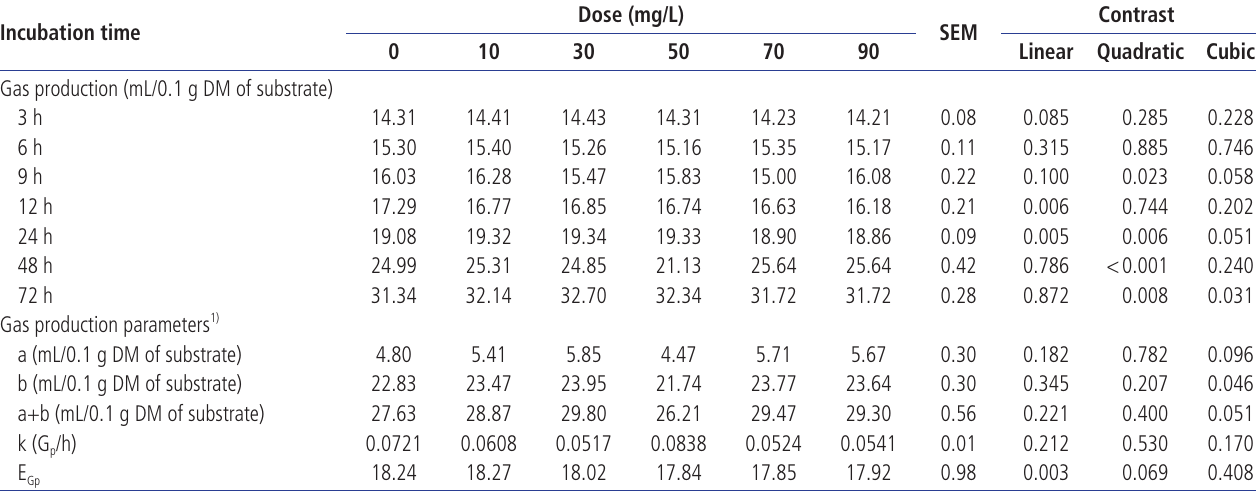
Table 2. Effects of different doses of Rhus succedanea extracts on in vitro cumulative gas production by mixed rumen anaerobic microbial fermentation Incubation